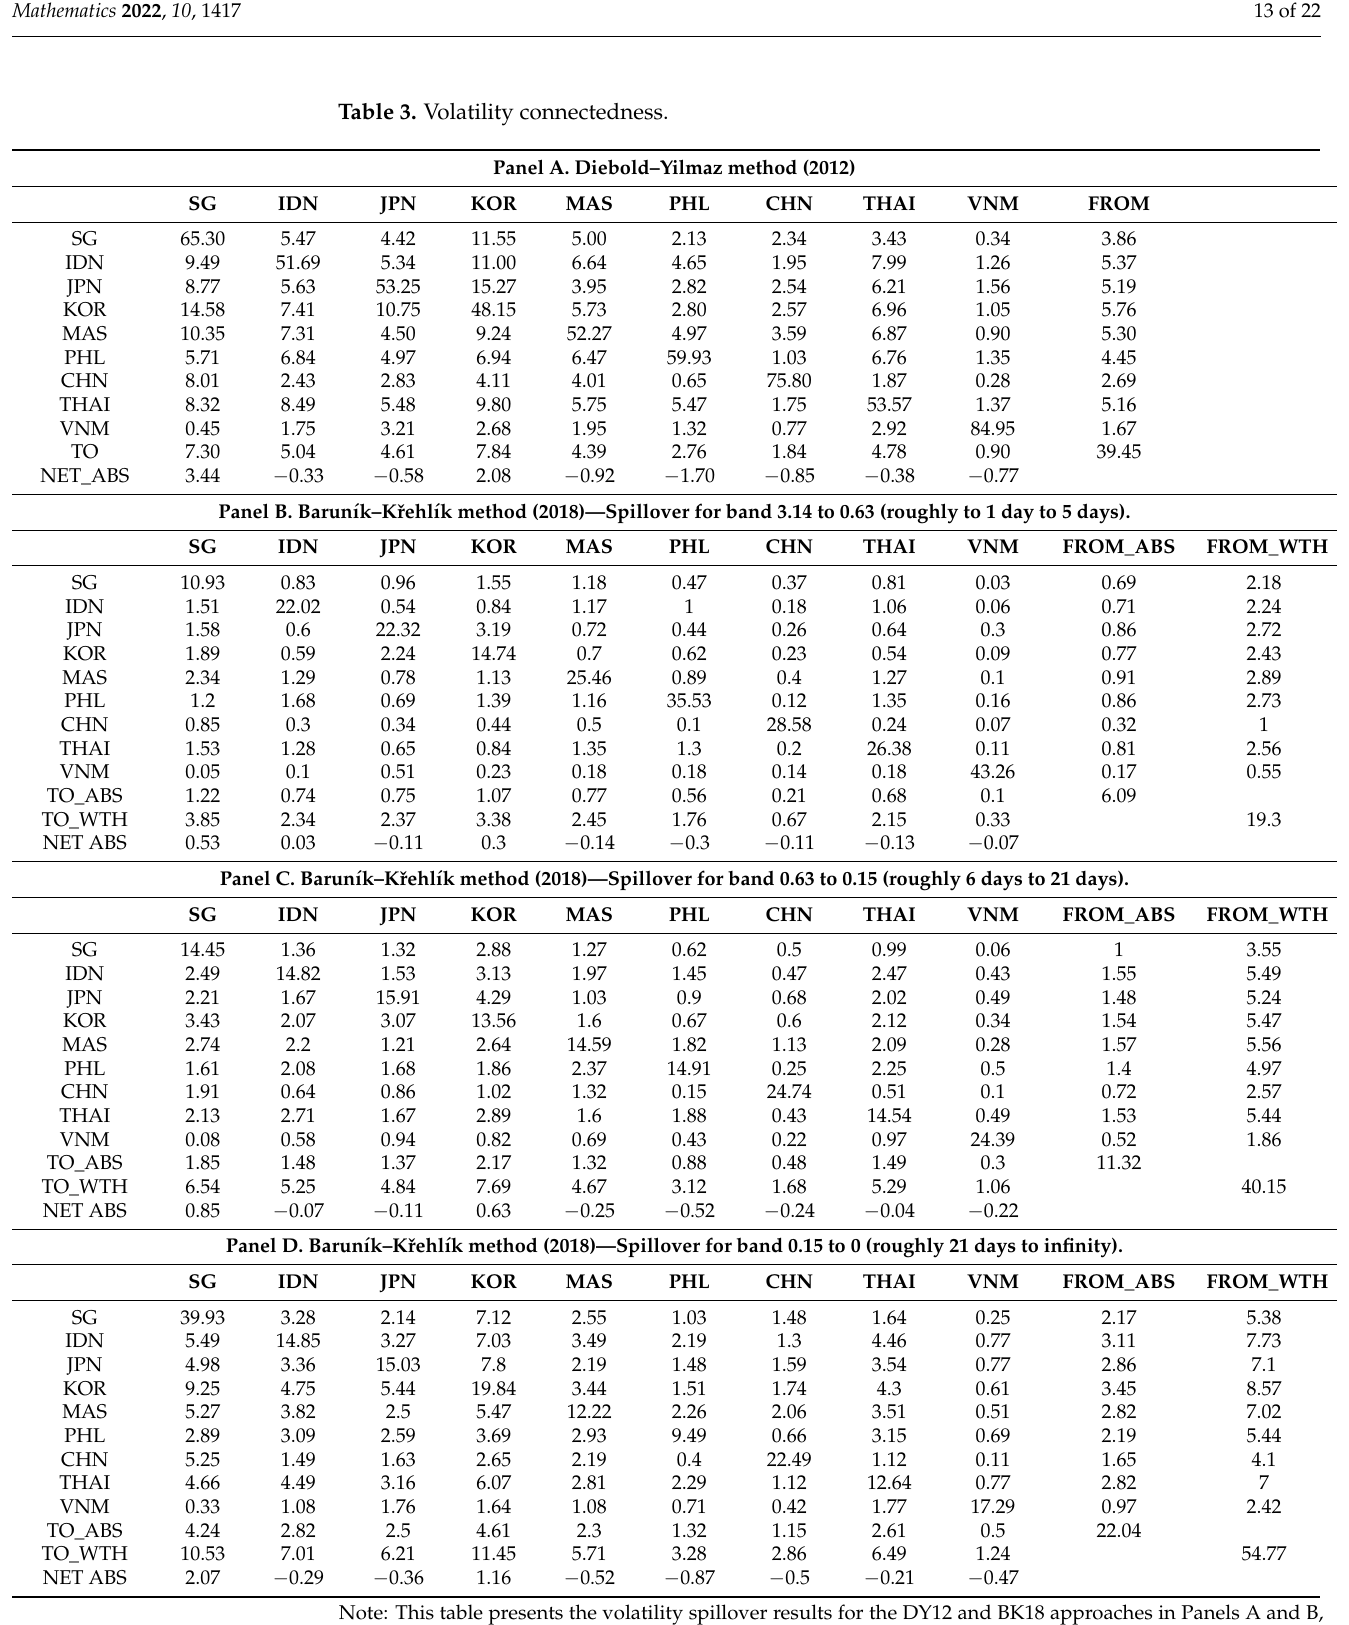
Table 3. Volatility